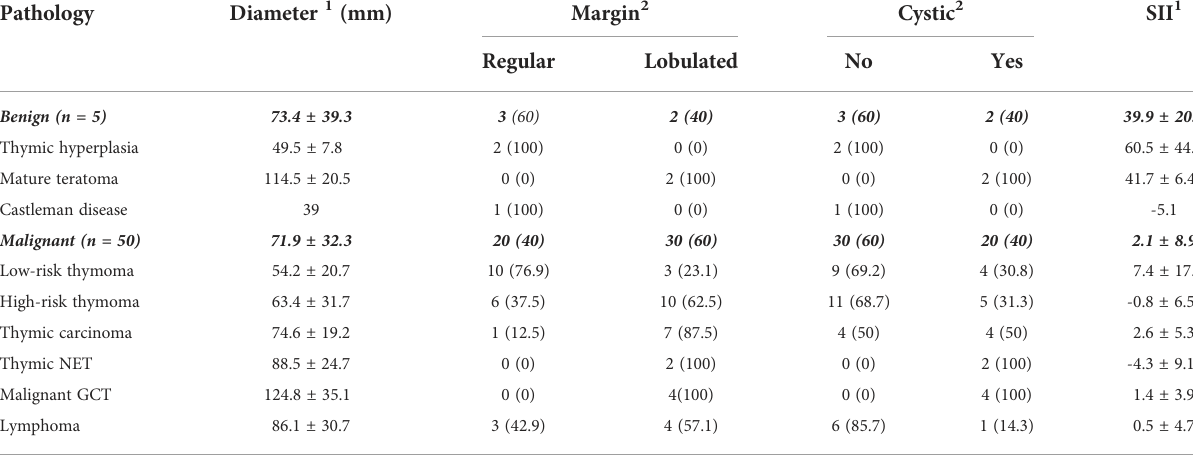
TABLE 2 Relationship between MRI fi ndings and pathological diagnostics.